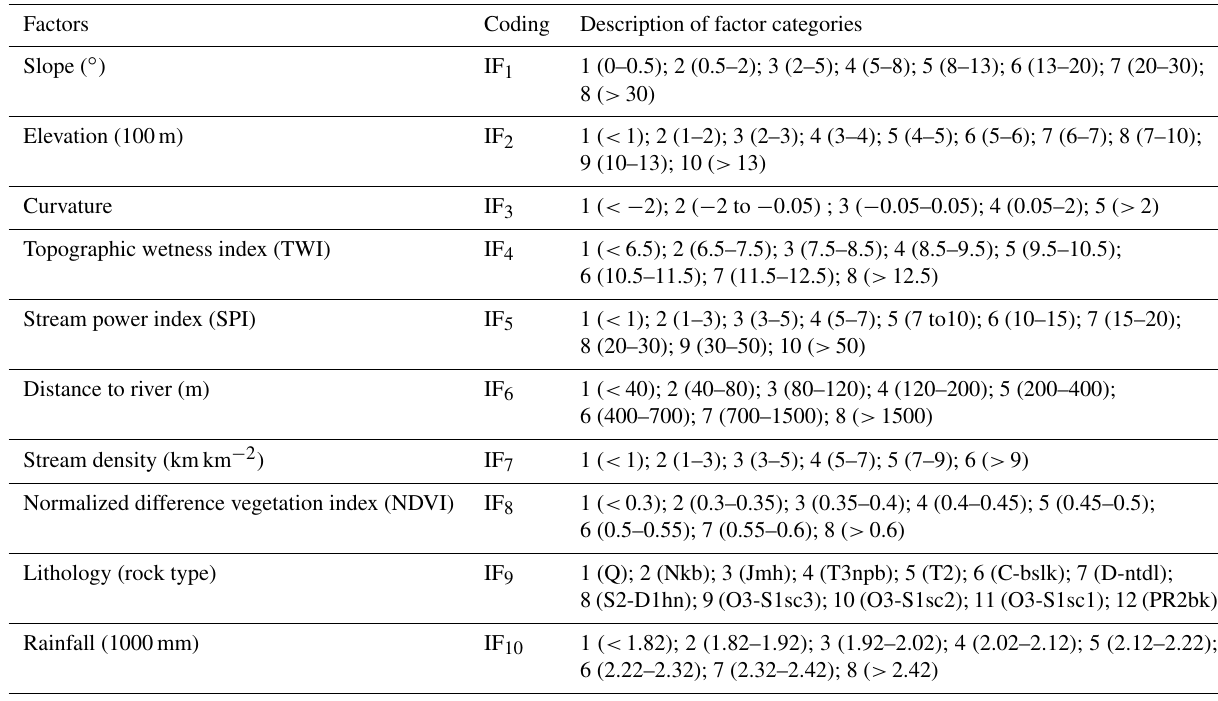
Table 1. Flood-influencing factors and their categories. Factors Coding Description of factor